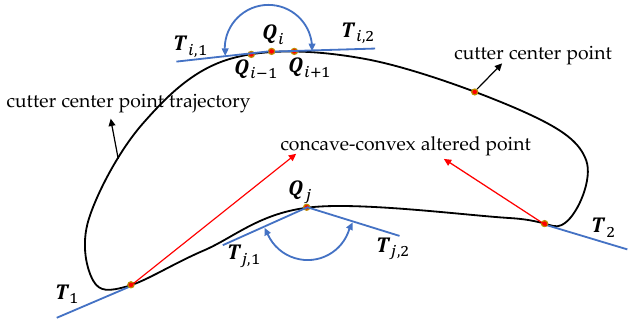
Figure 4. The selection of the limit vectors.